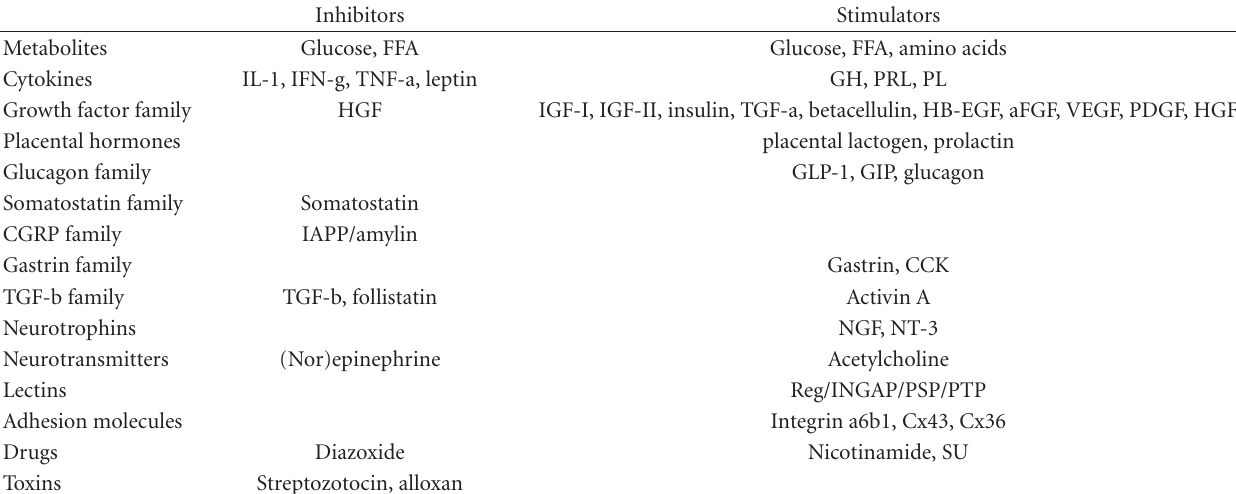
Table 1: Hormones, growth factors, and other factors regulating beta-cell